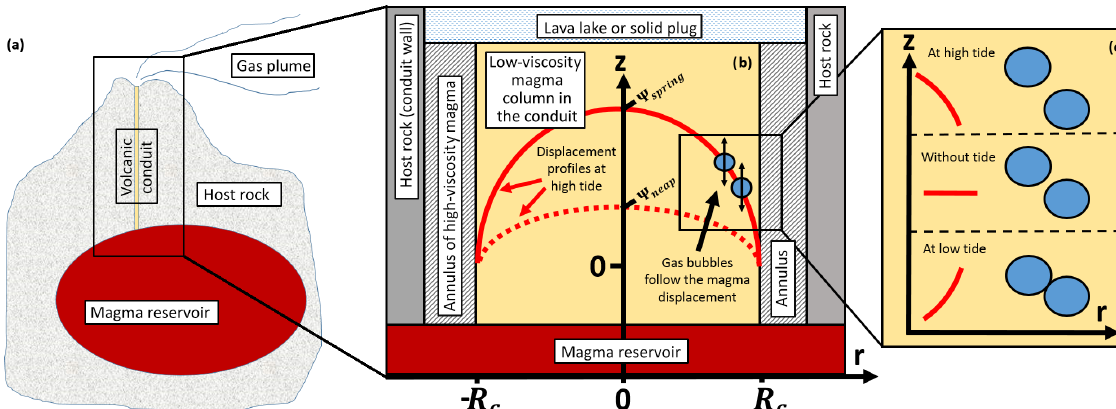
Figure 1. Panels (a) and (b) : sketch of the model set-up. The model compartments are indicated by white boxes but not depicted to scale. (b) The semi-diurnal tide causes a radial magma displacement profile in the conduit with different amplitudes during spring tide and neap tide. (c) Concept of the tide-enhanced bubble coalescence: two bubbles which are initially close to each other (see “without tide”) exhibit differential vertical tide-induced displacements, which enhances the chance for bubble coalescence (here “at low tide”).